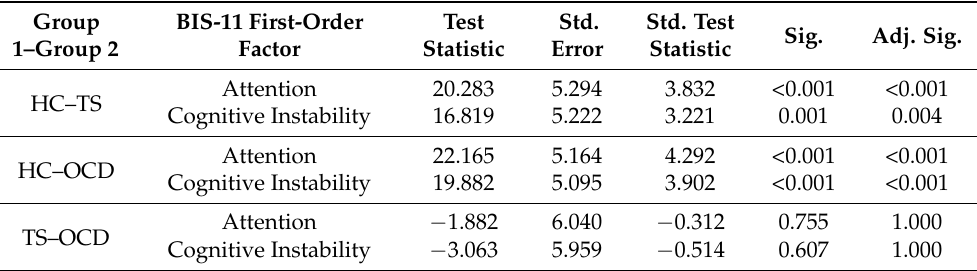
Table 3. Th post-hoc Bonferroni test of the first-order factors attention and cognitive insatiability (be- longing to the second-order factor attentional impulsivity) of the BIS-11 questionnaire. Abbreviations: Adj., Adjusted; HC, healthy control subjects; OCD, obsessive-compulsive disorder; Sig., Significance; Std., Standard; TS, Tourette